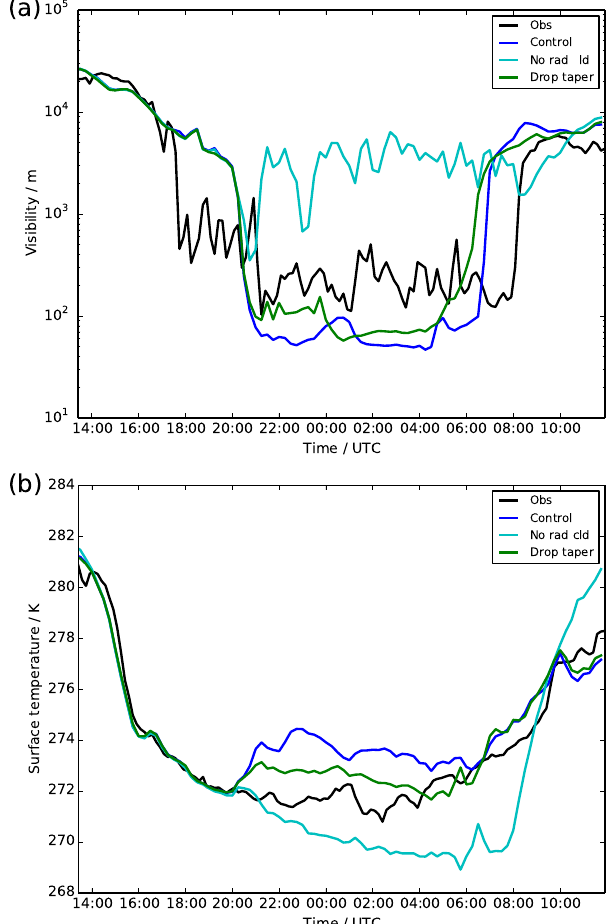
Figure 1. Time series of observations (black) and UKV experi- ments: control (blue), radiatively inactive cloud (cyan) and modified droplet number (green), showing (a) visibility and (b) grass-surface